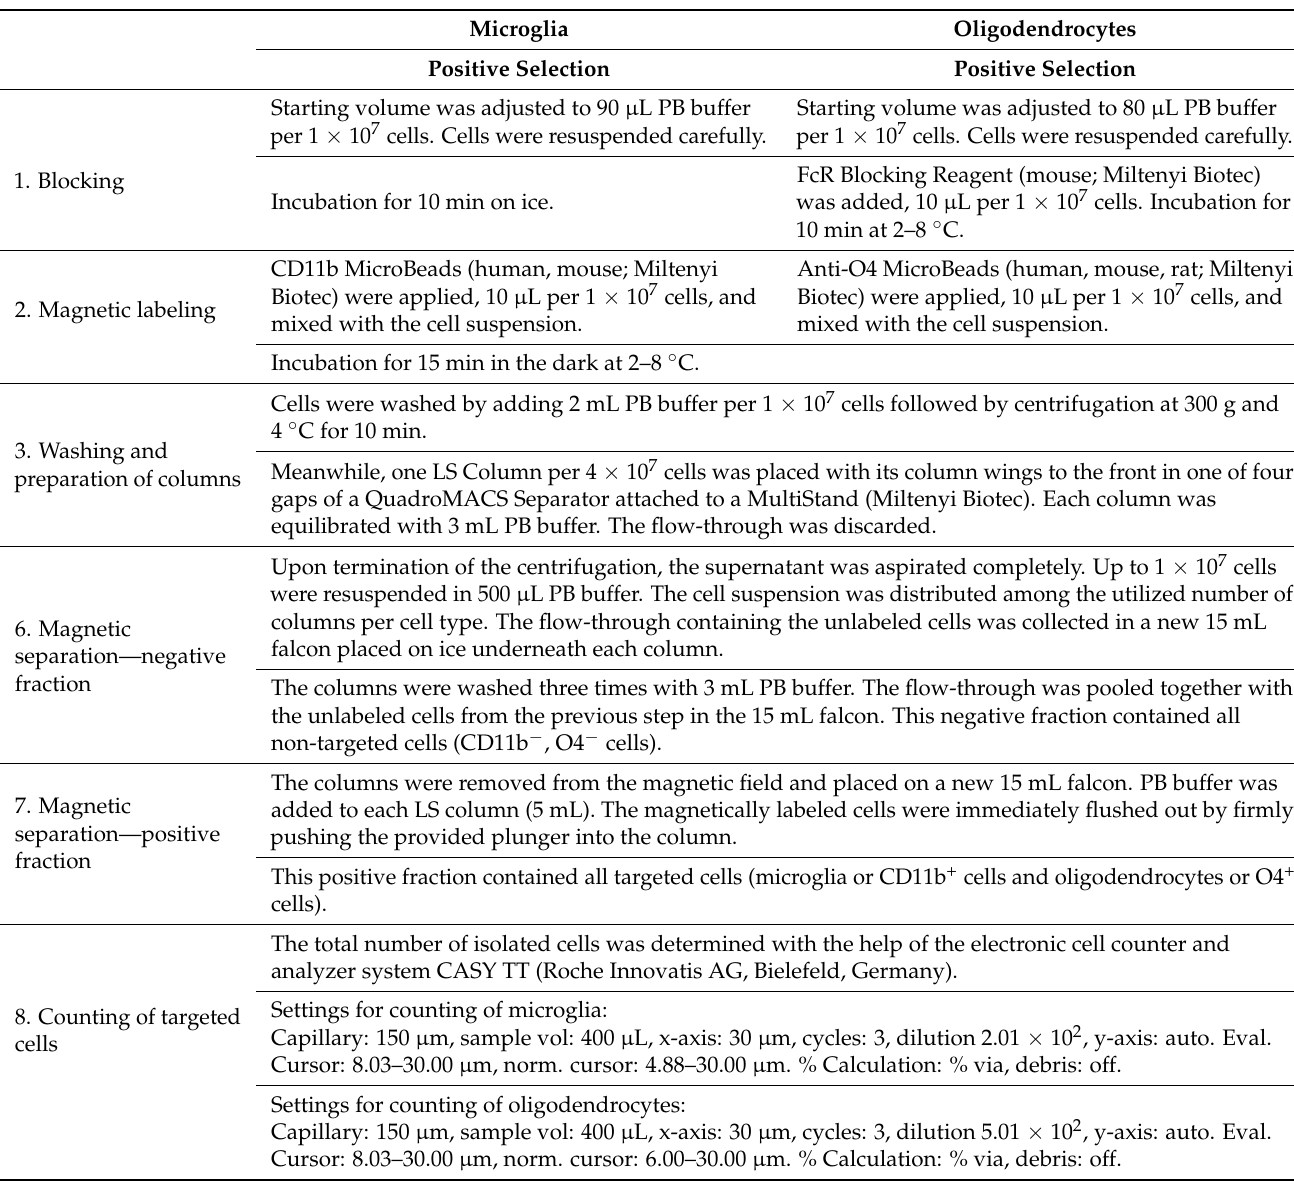
Table 1. Protocol for simultaneous MACS of microglia and oligodendrocytes from naïve and EAE mice. Steps that should be performed at once are listed in the same